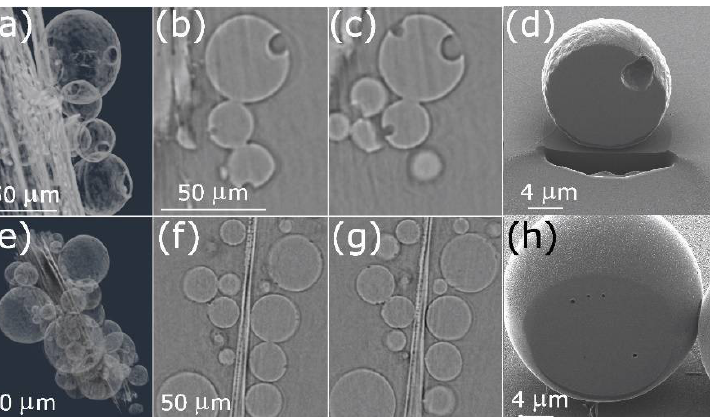
Figure 3. X-ray microscopy tomographic reconstructions of MEH-PPP in 3D view ( a ) and in 2D slices separated by 1.5 μm in vertical distance ( b , c ). An FIB cut through a representative single violet microsphere is shown in ( d ). The MEH-PPP microspheres generally contain single large dimples near the surface. ( e – h ) A similar sequence of tomographic reconstructions and FIB cut for MEH-PPV (see online Visualization 1). A few voids or holes are present but are smaller and more uniformly scattered throughout the particle.